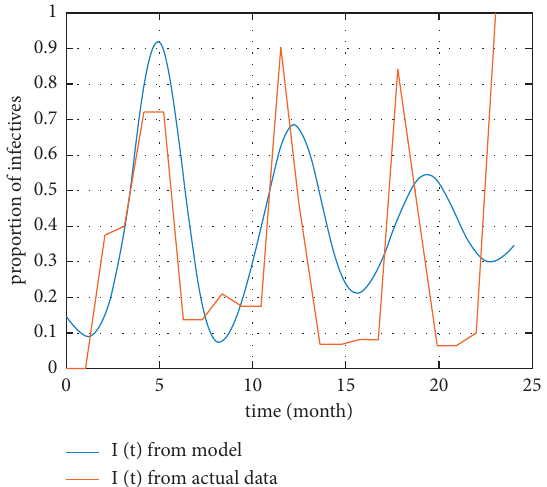
Figure 12: Proportion of the infective from March 2020 to January 2022.